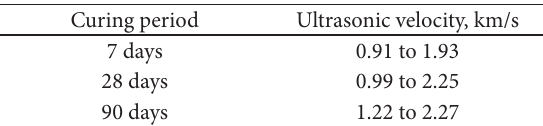
Table 2. Range of ultrasonic velocity results for different curing periods